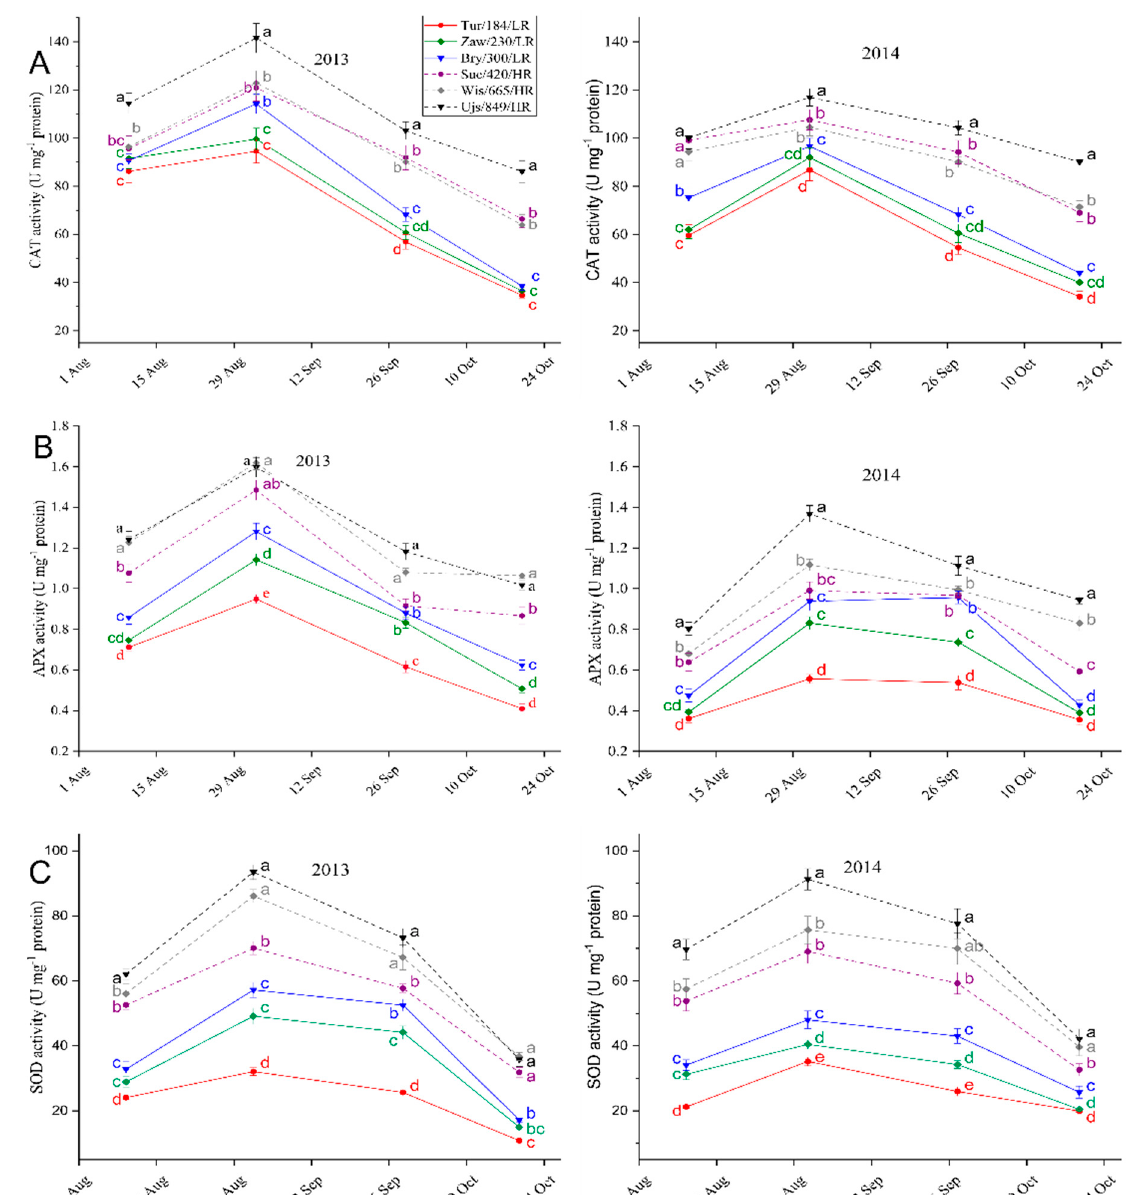
Figure 6. Changes in catalase (CAT) ( A ), ascorbate peroxidase (APX) ( B ) and superoxide dismutase (SOD) activity ( C ) in the leaves from different provenances of beech trees ( Fagus sylvatica L.). Analyses were performed for provenances from high-altitude (dashed line) and low-altitude (solid line) regions in 2013 and 2014. Each point is the mean of 15 measurements (±SE). Means with different lowercase letters for each sampling date differ significantly at p < 0.05.